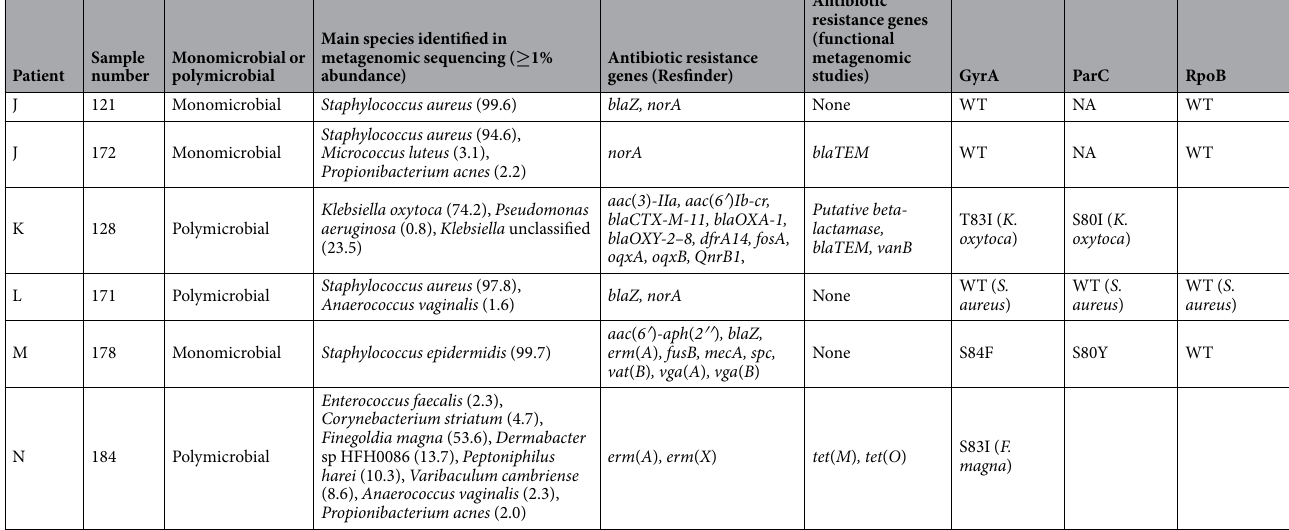
impact of downsizing was observed in both monomicrobial and polymicrobial samples (Extended Data Figs 12 and 13).